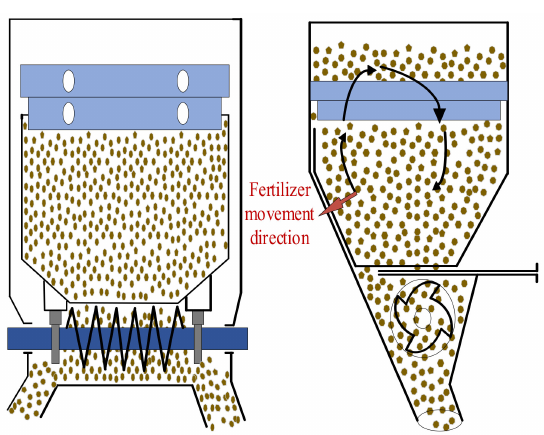
Figure 5. Centrifugal fertilizer ejector. (3) When the vibrating fertilizer ejector operates, the rotating fertilizer discharging cam causes the fertilizer discharging vibrating plate to vibrate continuously (Figure 6). Under the dual action of vibration and its own gravity, the fertilizer in the fertilizer box slides along the slope of the vibrating plate and is discharged through the fertilizer discharging port. The vibrating fertilizer ejector is suitable for granular and highly hygroscopic powdery fertilizers. It has a wide application range and simple structure.